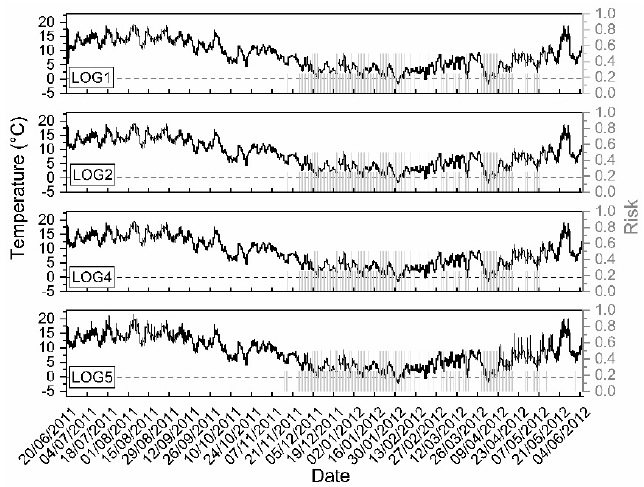
Figure 8. Indoor temperature data from the four data loggers collected between 20/6/2011 and 13/6/2012 every 2 h. Dotted lines indicate T = 0 °C. Grey vertical lines indicate the level of risk (right y -axis).